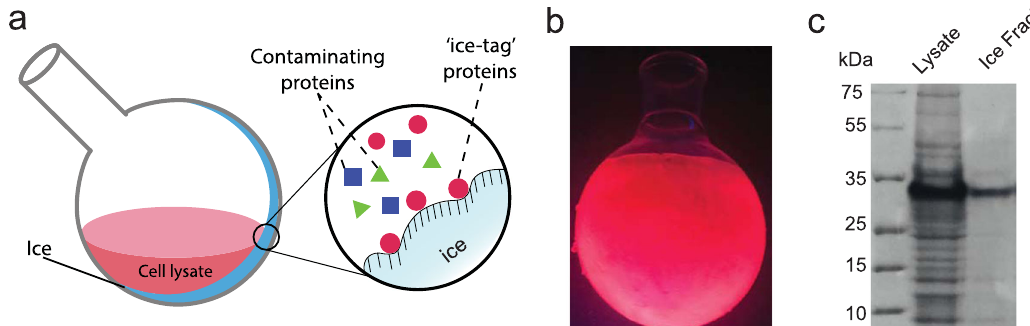
Fig. 9 ‘ Ice-tag ’ ice-af fi nity puri fi cation of mCherry. a Schematic representation of ‘ ice-tag ’ ice-af fi nity puri fi cation. b Ice shell imaged under UV light. c SDS-PAGE of E. coli cell lysate containing overexpressed mCherry and fraction that bound ice from the ice-af fi nity puri fi cation. Experiments were performed in triplicate.